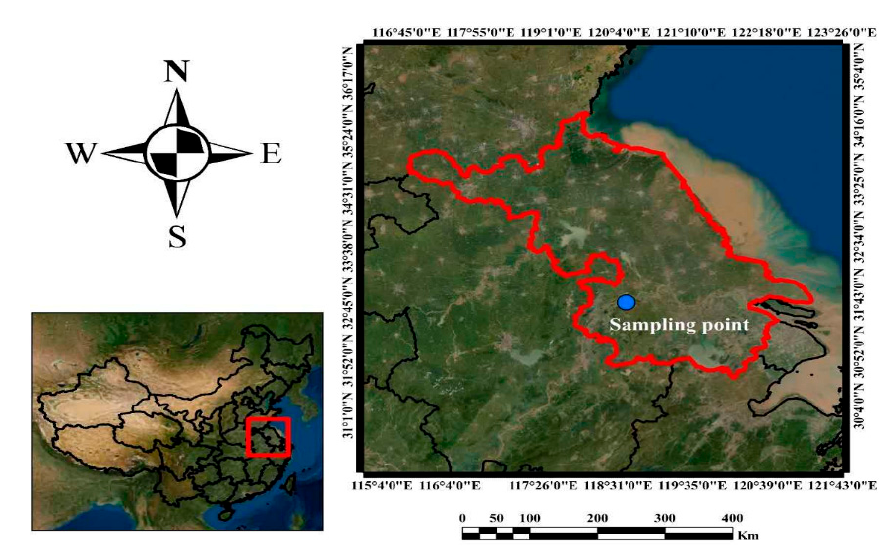
Figure 1. Location of studied area (Nanjing mine).